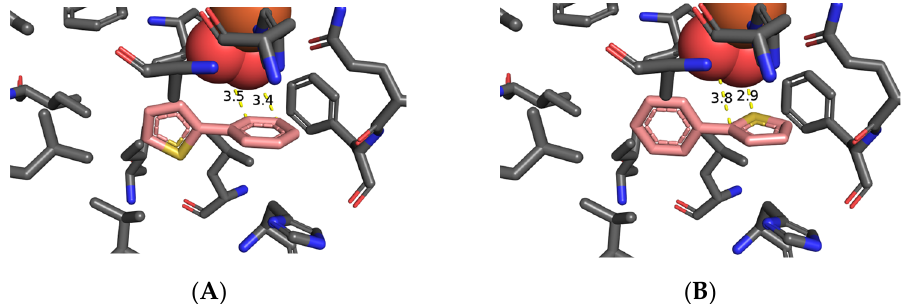
Figure 2. Preferred orientation of 2-phenylthiophene 1g for TDO-catalyzed: cis -dihydroxylation ( A ) and sulfoxidation ( B ).